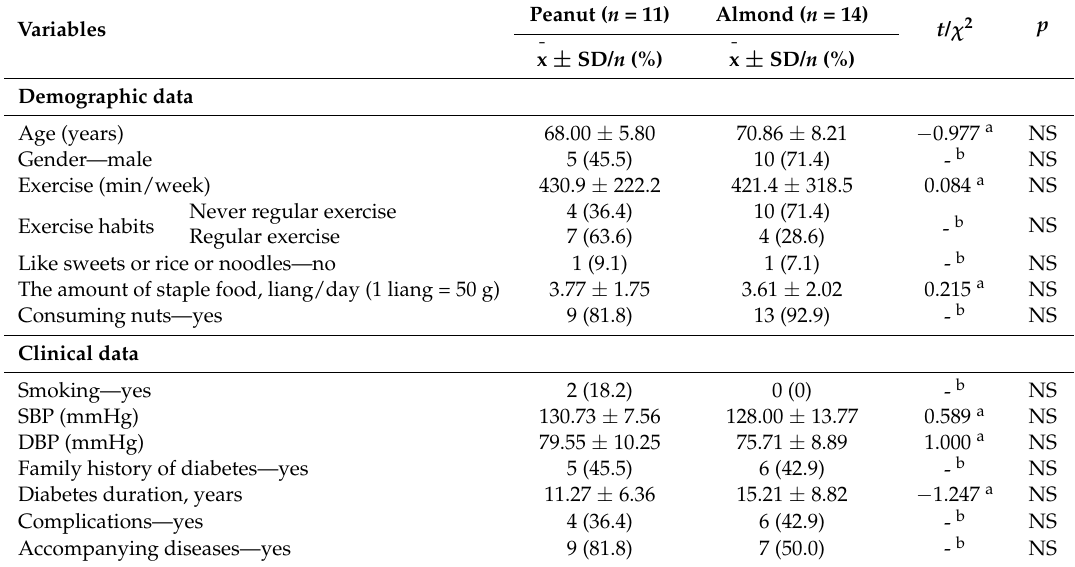
Table 1. Baseline characteristics.